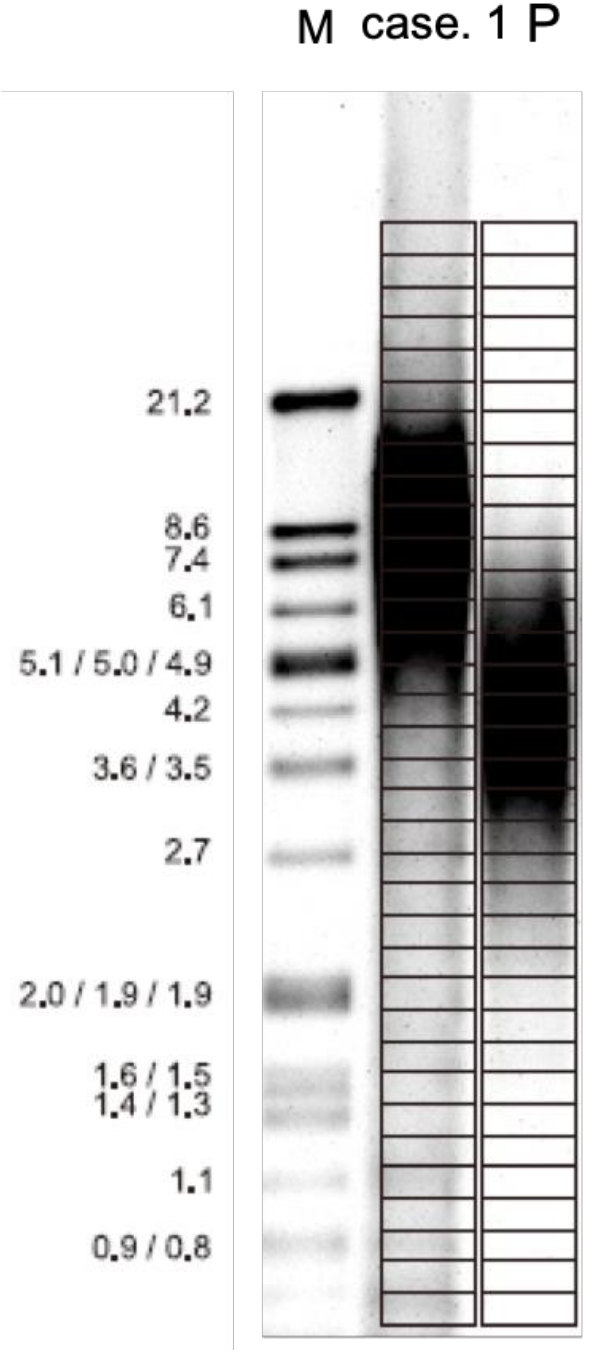
Figure 9. Telomerase length assay. Under the culture of this new formula, the HBMSCs of case 1 can maintain their length of telomere of 8 Kb, which is nearly the same as the length of the cells in newborns. M: marker, P: positive control.